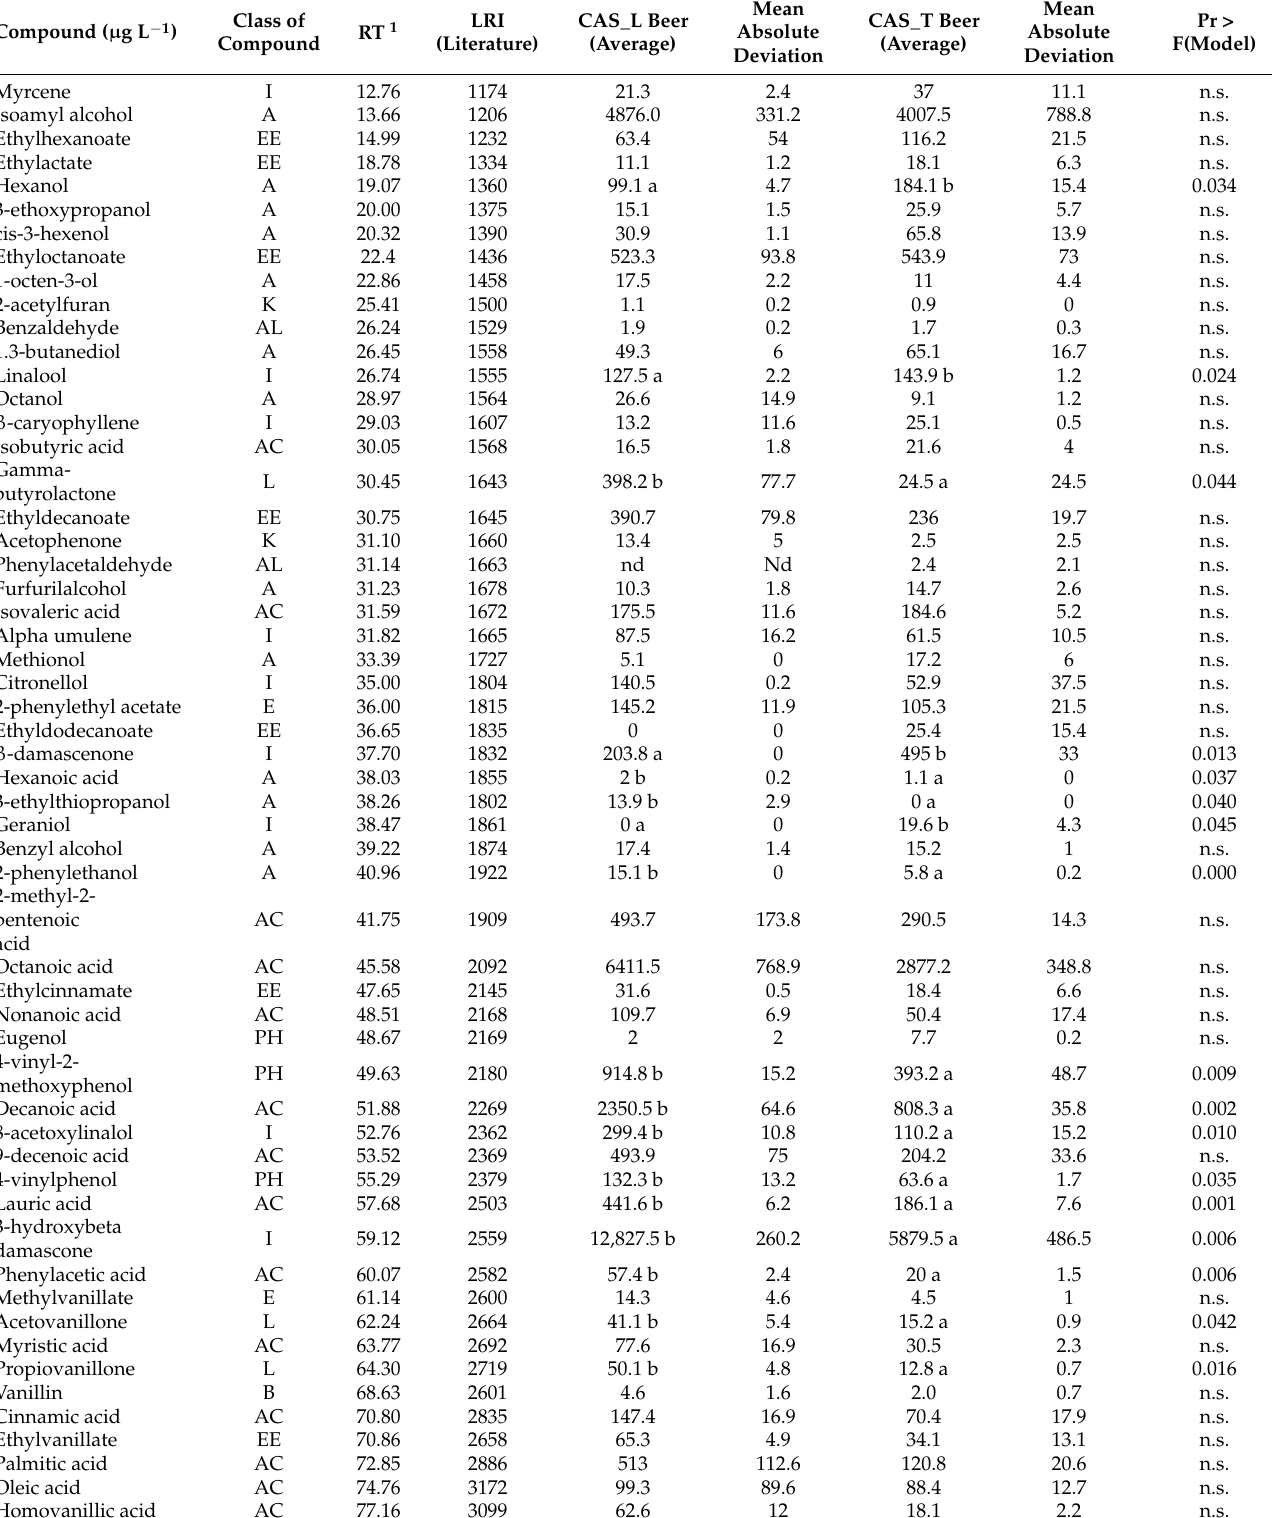
Table 7. Average contents of aromatic compounds ( µ g L − 1 ) present in CAS_L beer and CAS_T